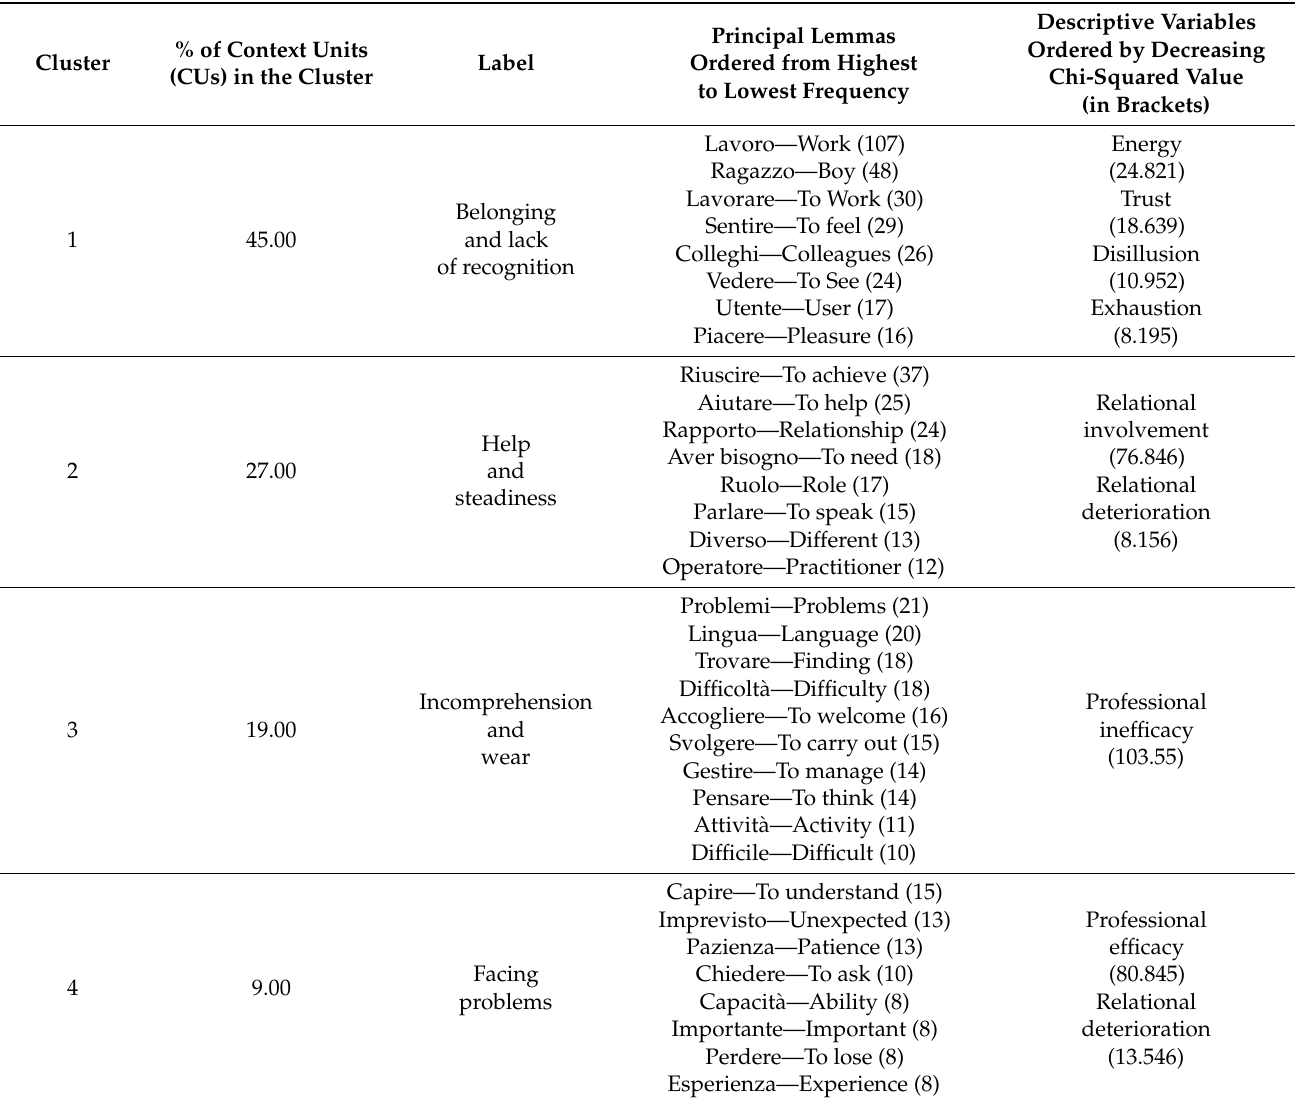
Table 3. Results of cluster analysis on second-level